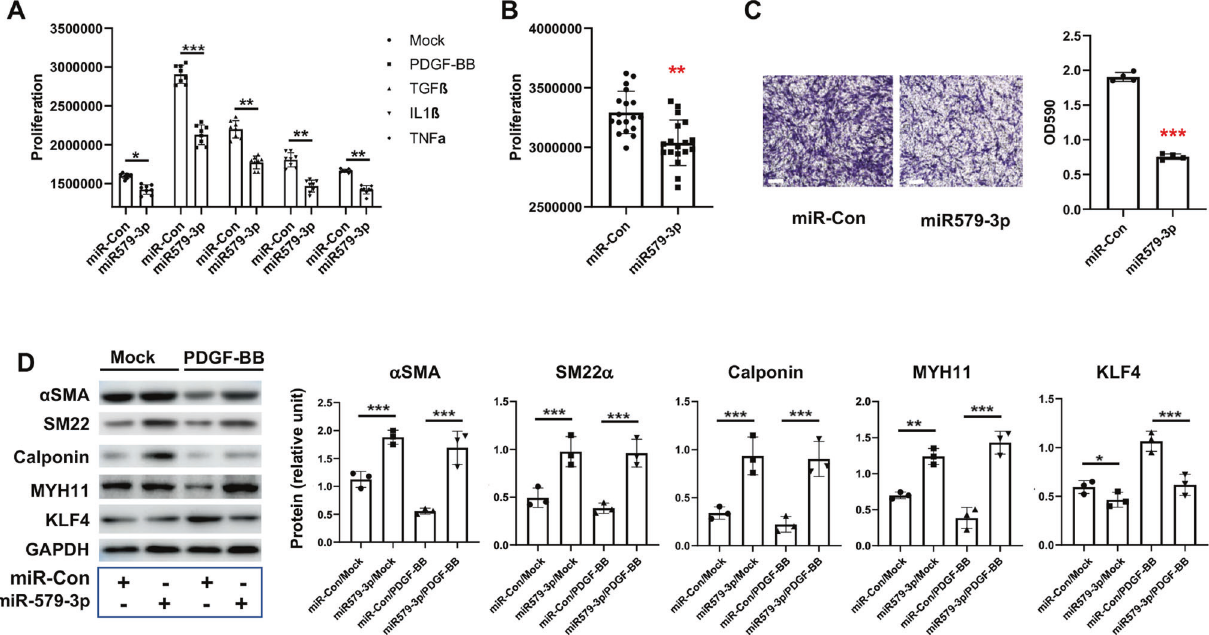
Fig. 2 miR579-3p suppresses AoSMC proliferation, migration, and de-differentiation. A , B Proliferation assay. AoSMCs starved in basal medium (no FBS, 24 h) were transfected with miR-con or miR579-3p for 24 h. The medium was then changed to fresh basal medium with or without a cytokine ( A ) (50 ng/ml PDGF-BB, 20 ng/mL TGF β 1, 20 ng/ml TNF α , or 10 ng/ml IL1 β ) or full medium ( B ) for an additional 24 h before the CellTiter ‐ Glo viability assay. C Migration assay. AoSMCs were seeded in the Transwell insert, the lower chamber fi lled with full medium. Cells that migrated to the lower surface of the insert were imaged after a 24 h incubation. To quantify the migration, 33% (v/v) Acetic acid was added into the insert to elute the bound crystal violet, and then the eluent from the lower chamber was measured for absorbance (590 nm) using a 96-well microplate reader. Scale bar: 200 μ m. D De-differentiation (Western blotting of SMC contractile proteins). AoSMCs were starved (no FBS, 24 h) and transfected with miR-con or miR579-3P for 24 h, and then treated with or without 50 ng/ml PDGF-BB for another 24 h. Quanti fi cation for A-D: Mean ± SD ( A and B , see dot plots for the number of replicates) or mean ± SEM ( C and D , n = 3 independent repeat experiments). Pairwise comparison was made through Student ’ s t -test. ** P < 0.01, *** P <